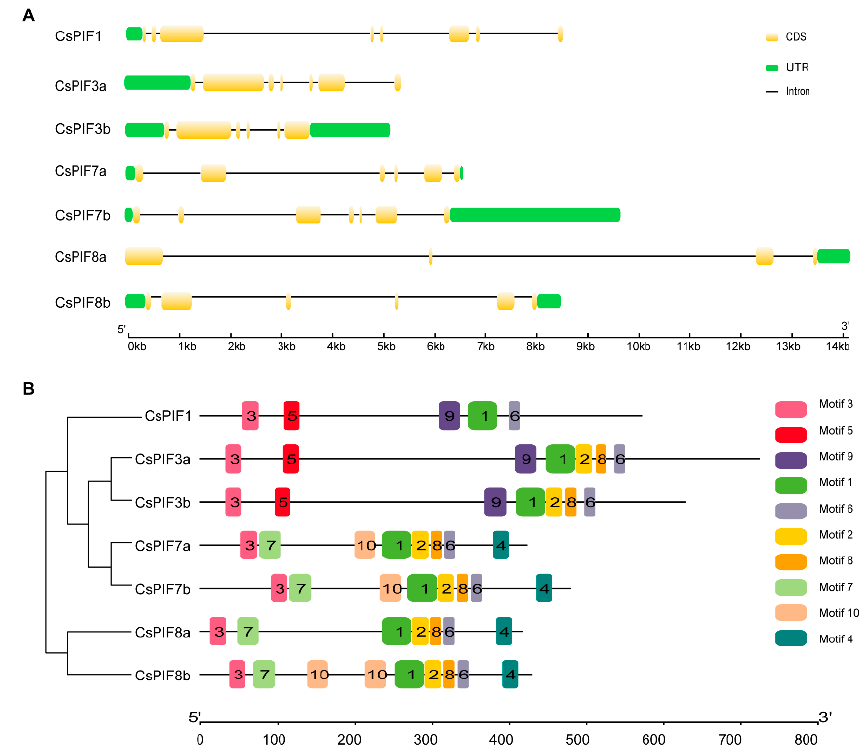
Figure 3. Gene structure and motif composition in CsPIF family. ( A ) The diagram was drawn using the online Gene Structure Display Server (GSDS 2.0) (http://gsds.gao-lab.org (accessed on 8 July 2021)) with full-length gene sequence and CDS sequence of CsPIF genes. CDS and UTR are indicated by yellow and green boxes respectively, and introns are represented by gray lines. ( B ) The motifs, numbers 1–10, are represented by different colored boxes. The information of each motif is provided in Table S3.